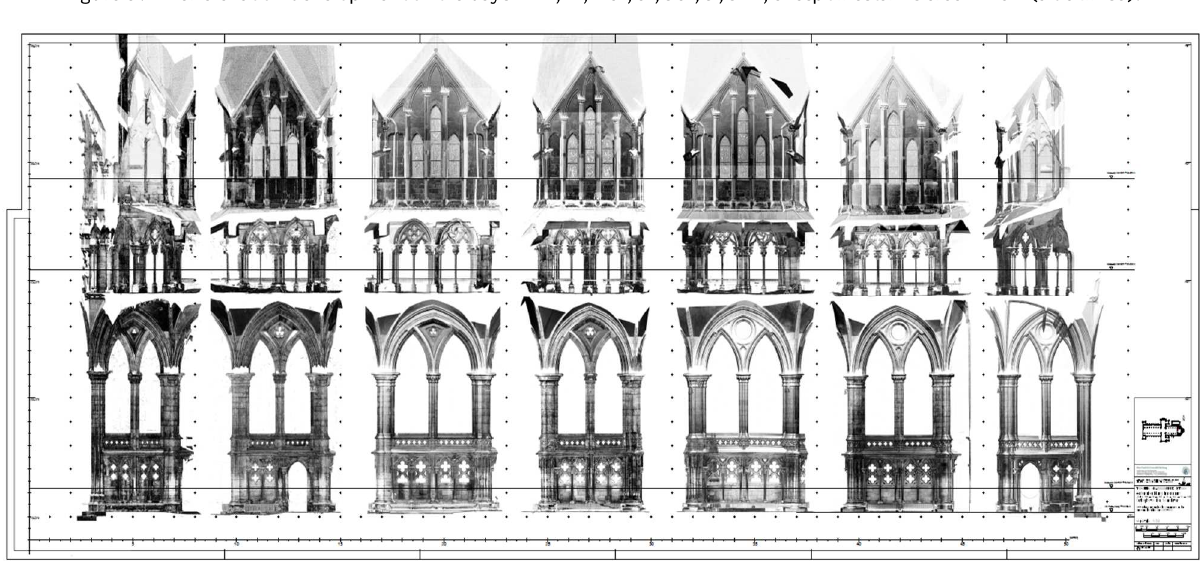
Figure 4. Outer elevation development (from deambulatory) of the same bays SW, S, SO, O, NO, N, NW